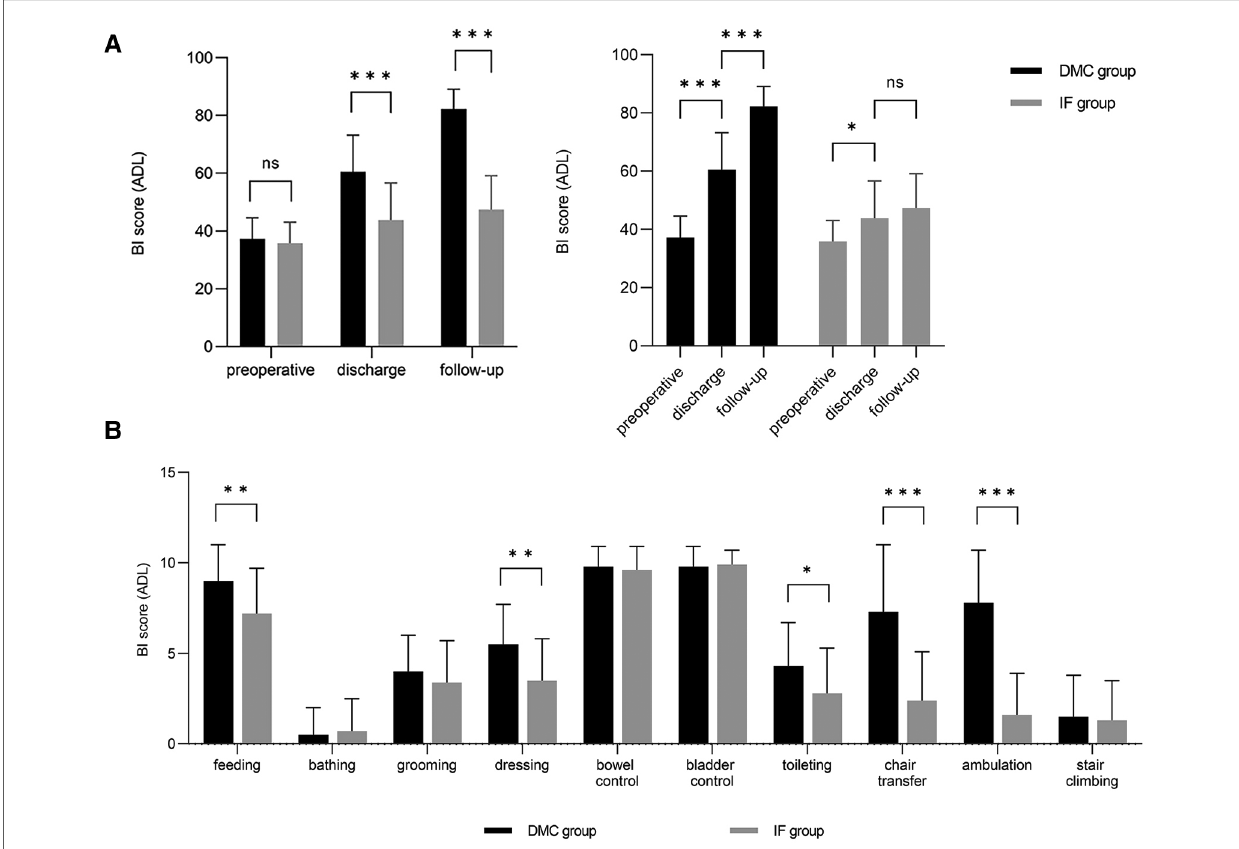
FIGURE 1 Scores for patient-related ADL assessed with the BI. The results of the DMC group cohort are shown in black and the IF group cohort are illustrated in grey. ( A ) Comparison and Change trend of ADL between DMC group and IF group at different time points. ( B ) Comparison between DMC group and IF group on subdimension scores of